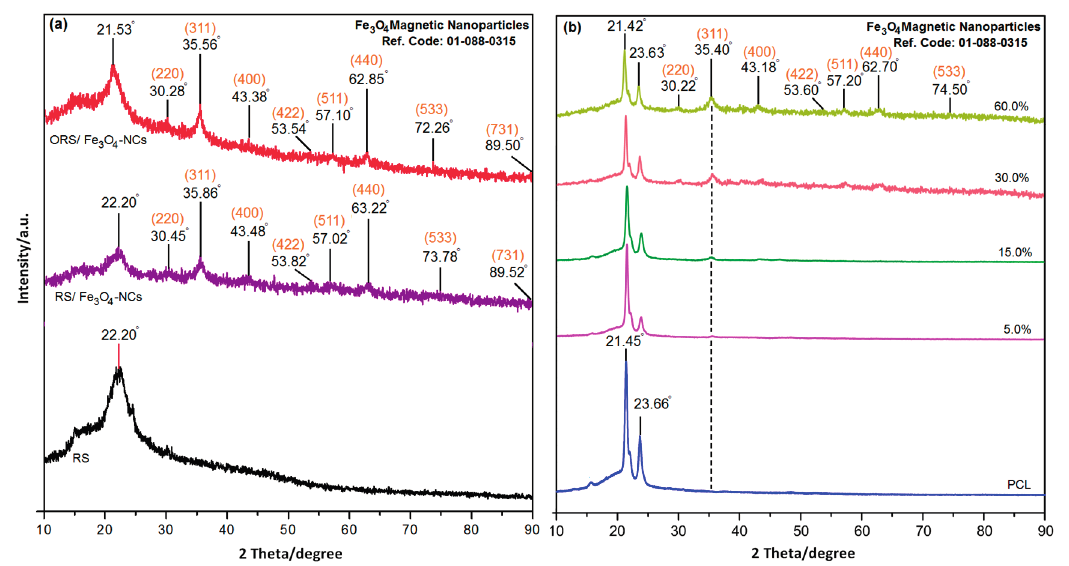
Figure 1. XRD pattern of RS, and RS/Fe 3 O 4 -NCs, and ORS/Fe 3 O 4 -NCs ( a ) PCL; and ORS/Fe 3 O 4 /PCL-NCs in 1.0, 5.0, 15.0, 30.0 and 60.0 wt. % ( b